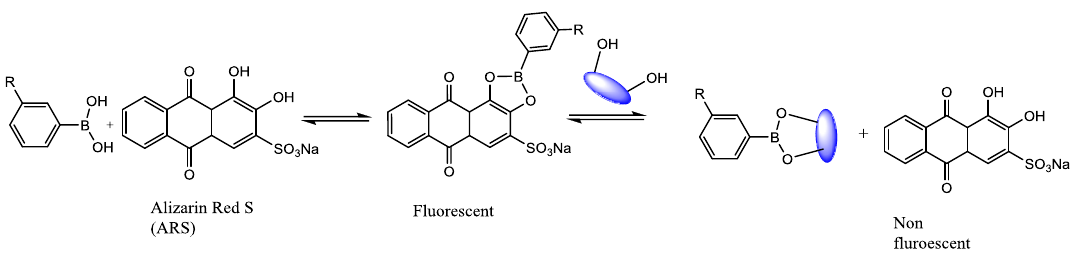
Figure 3. Competitive binding of phenylboronic acid (PBA) with Alizarin Red S (ARS) and glucose.